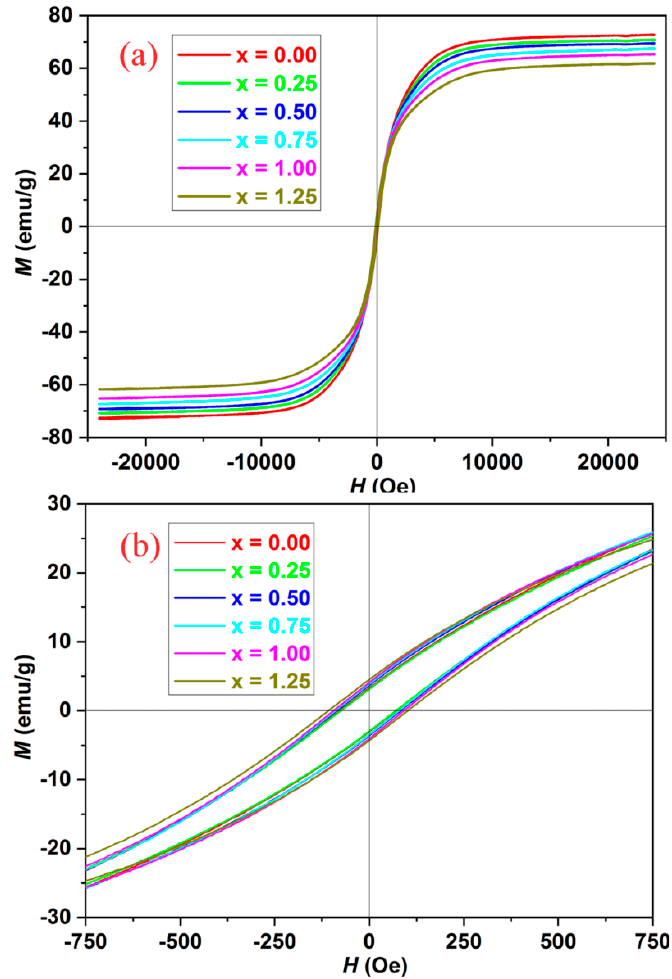
Figure 7. ( a ) Magnetic hysteresis loops with the maximum magnetic field of ±24,000 Oe, and ( b ) the magnified charts of magnetic hysteresis loops within the range of ±750 Oe, for the W-type SrYb hexagonal ferrite Sr 0.85 Yb 0.15 Zn 1.5 Co 0.5 Al x Fe 16-x O 27 .